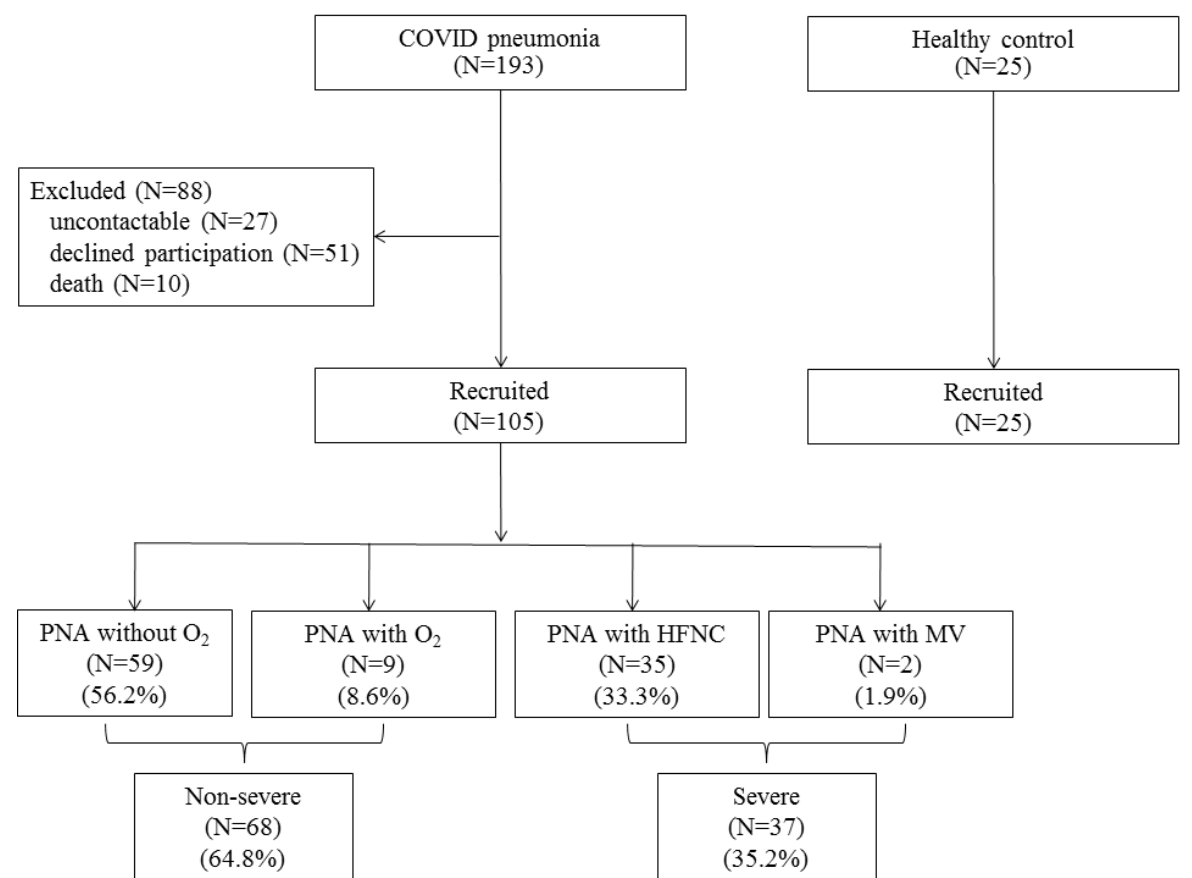
Figure 1. Flow chart of the study population. Abbreviations: PNA, pneumonia; HFNC, high-flow nasal cannula oxygen; MV, mechanical ventilation. Table 1. Demographic data of study population ( n = 130).